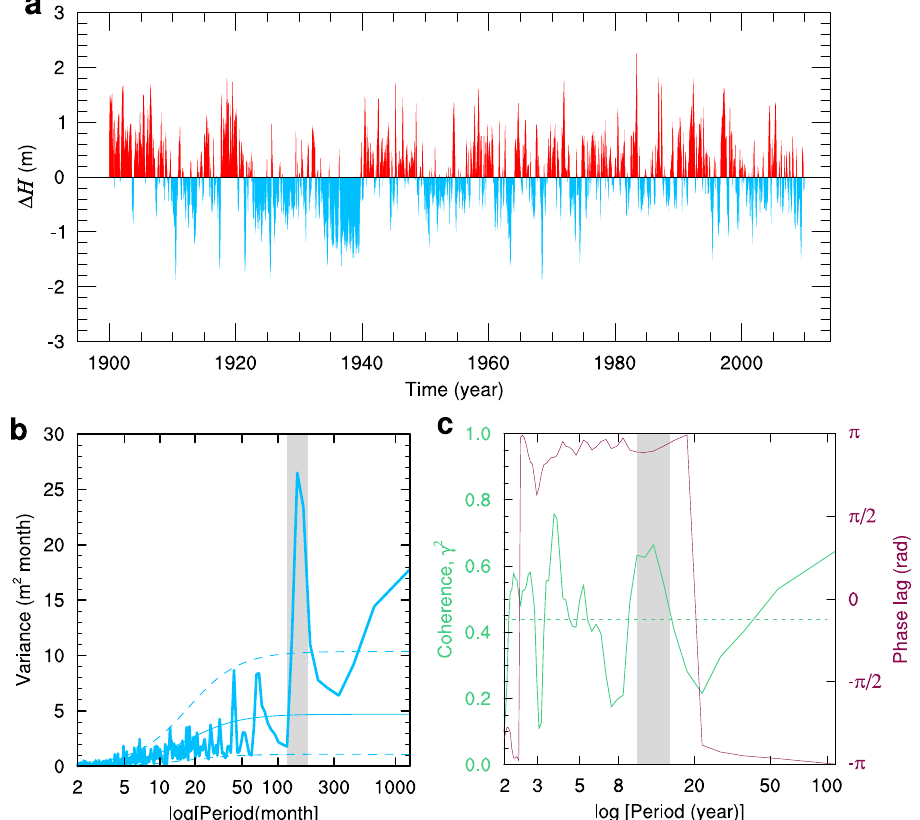
Fig. 5 Analysis of cold tongue dynamics. a Monthly Δ H time series and ( b ) spectrum (thick, solid curve); associated fi rst-order autoregressive curve (thin, solid curve) and the 95% con fi dence bounds (thin, dashed curves). c Coherence (left axis) and phase lag (right axis) between annual Δ H and Atlantic Niño index. The dashed horizontal line denotes 95% con fi dence level for spectral coherence. The Δ H leads at positive lags whereas Atlantic Niño leads at negative lags. The vertical bar in both panels shows the 10 – 15 year period